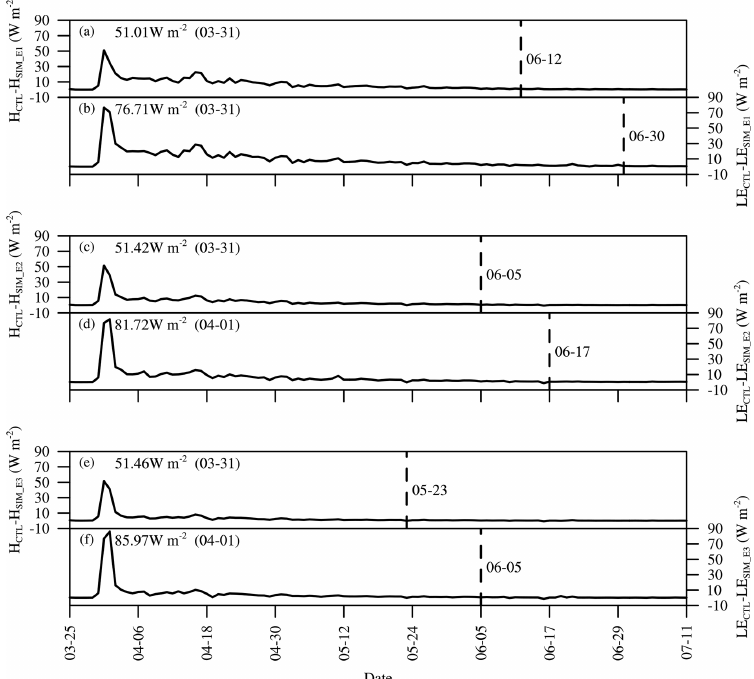
Figure 8. The difference in the daily average sensible and latent heat between the CTL and the three sensitivity simulations under the water temperature profiles in SIM_E1, SIM_E2, and